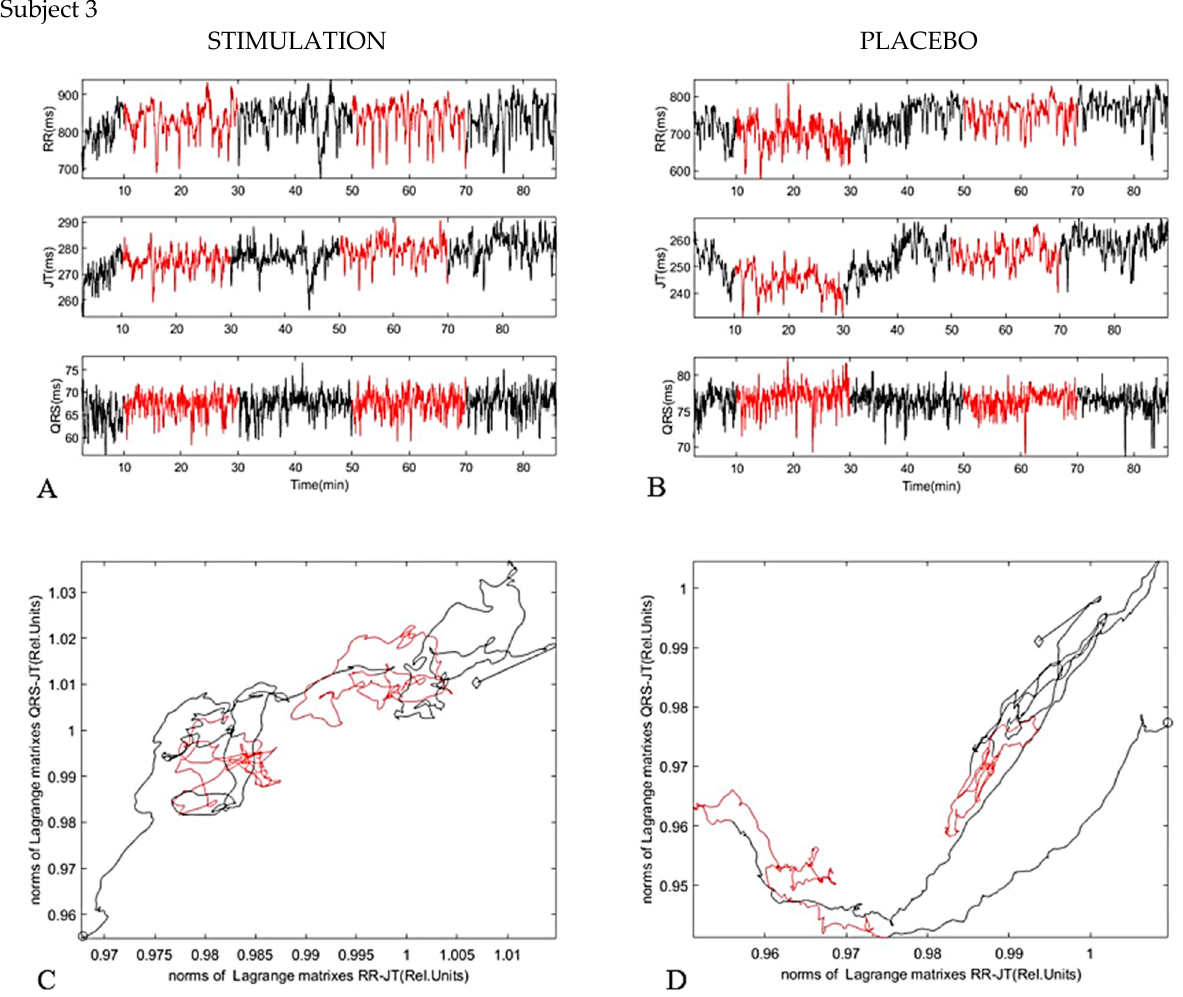
Figure 7. Subject 3. ( A ) dynamic of parameters RR interval, JT interval, and QRS duration during investigation (Stimulation). ( B ) dynamic of parameters RR interval, JT interval, and QRS duration during investigation (Placebo). ( C ) phase plane for JT/QRS and RR/JT norms during stimulation. ( D ) phase plane for JT/QRS and RR/JT norms during placebo.